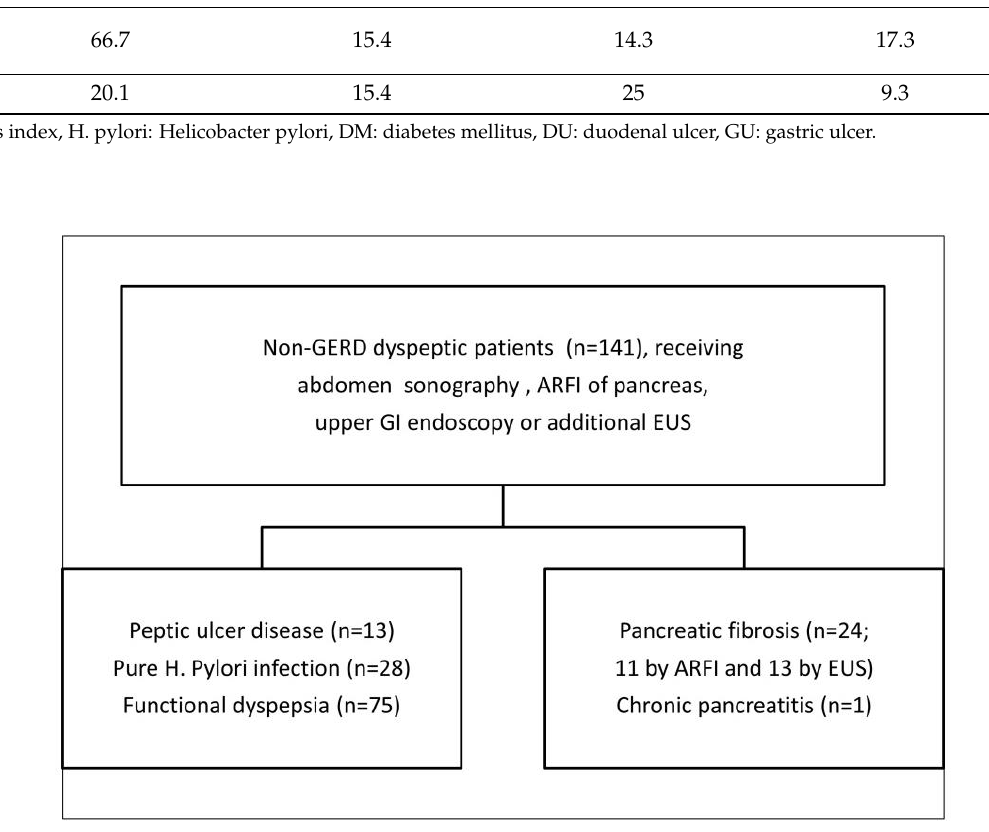
Figure 3. The numbers of each subgroup, GERD: gastro-esophageal reflux disease, GI: gastrointestinal, EUS: endoscopic ultrasonography, ARFI: acoustic radiation force impulse, H. pylori: Helicobacter pylori.